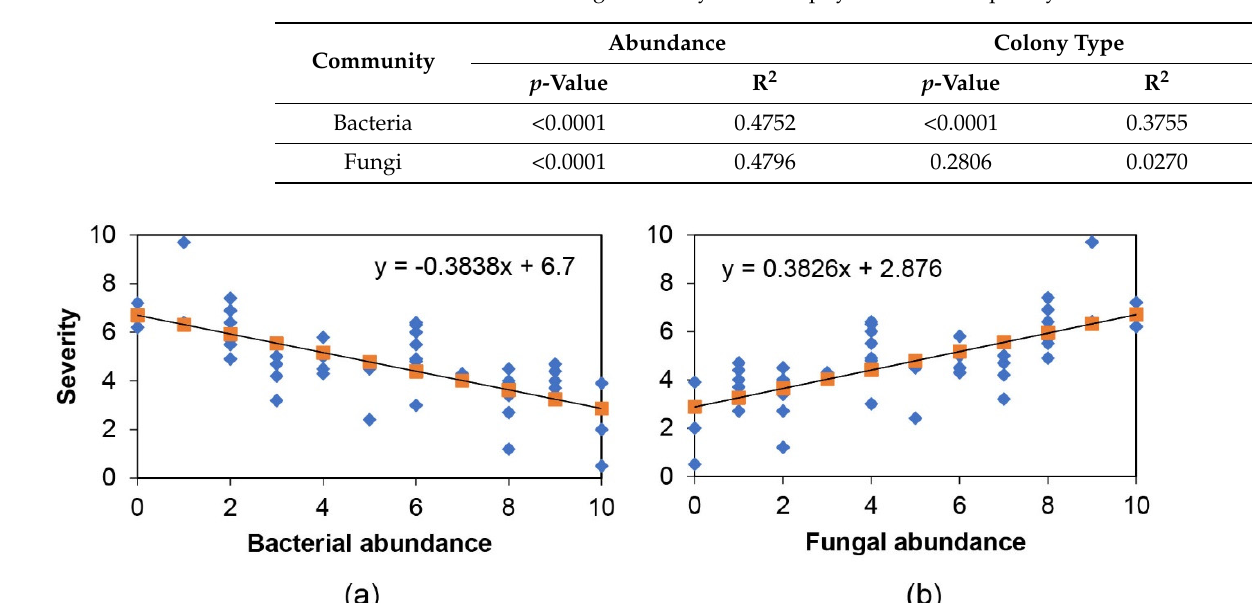
Figure 3. Correlation of boxwood blight severity with bacterial ( a ) and fungal ( b ) abundance in the summer sample culture dishes. Blue diamonds are the samples at the corresponding abundance level. Orange squares are points connecting the trend line.